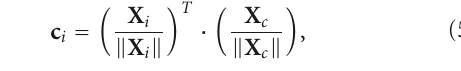
Figure 3 is a flowchart of the algorithm. The inputs on the left are constraints enforced at each stage. The inputs on the right are the parameter values at each stage. The signal is split into regions which contain kick drum and regions which contain bleed, as discussed in Section